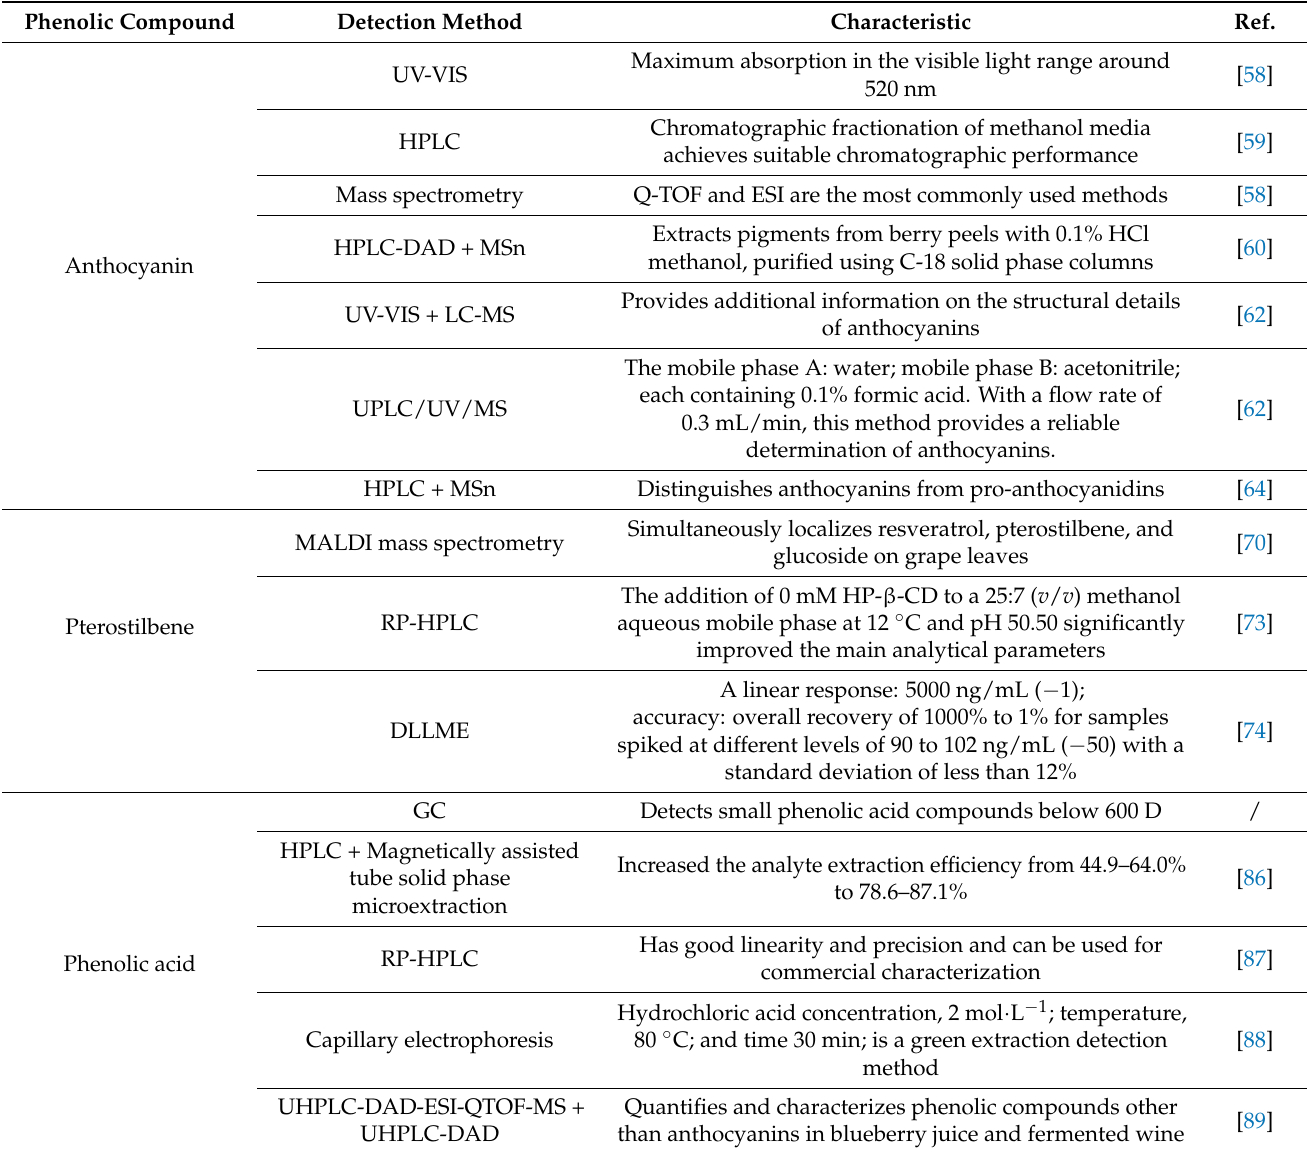
Table 3. Summary of the detection methods of phenolic compounds in blueberries in this